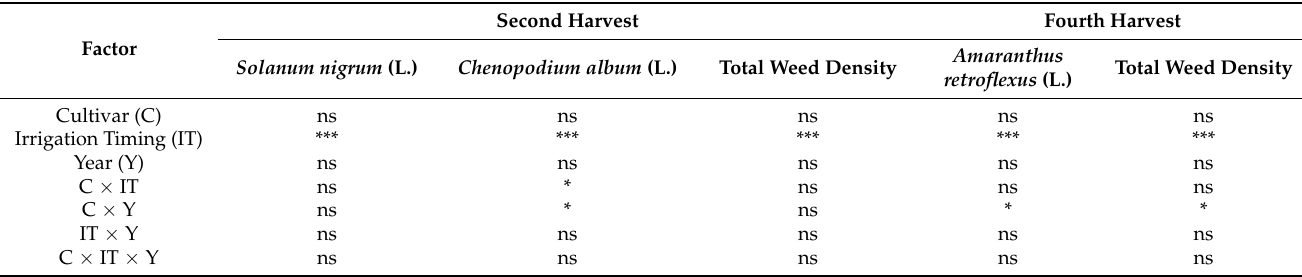
Table 3. The effects of the experimental factors on the weed density values recorded, in the second and the fourth harvest, across the two experimental years. Solanum nigrum and Chenopodium album L. were the dominant species during the second harvest. Amaranthus retroflexus L. was the dominant species during the fourth harvest. The p -values were derived from an analysis of